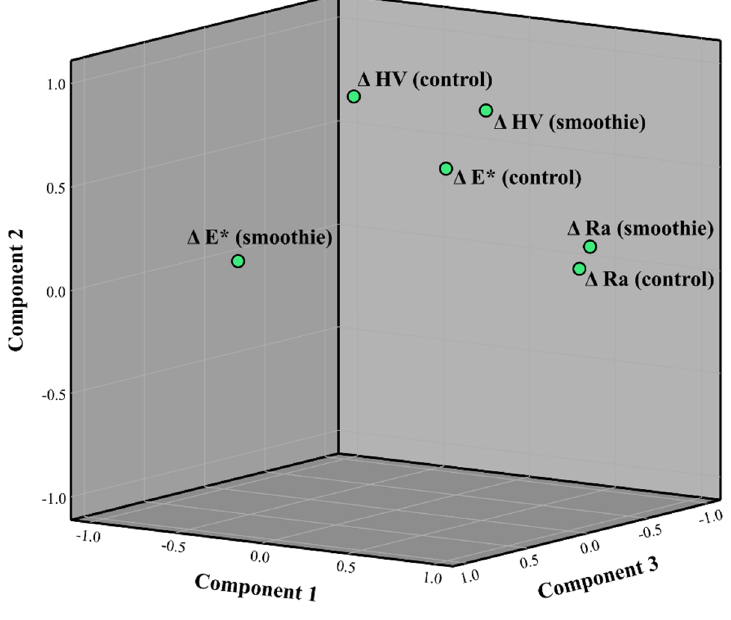
Figure 6. The component loading plot in rotated space for the variables representing the change of microhardness ( ∆ MH), profile roughness ( ∆ Ra), and perceptible color ( ∆ E*) within the smoothie and the control group.